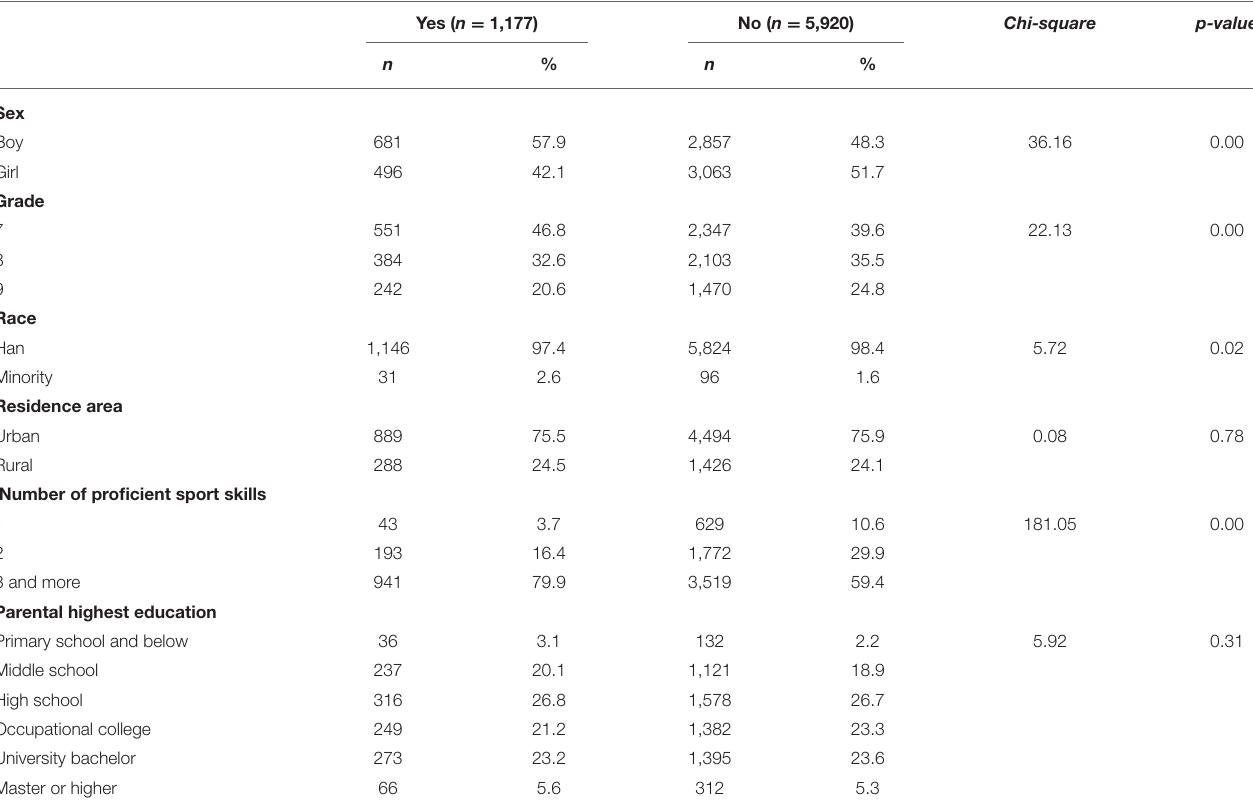
TABLE 2 | Prevalence of participation in organized sports activities by sociodemographic variables. Yes ( n = 1,177) No ( n = 5,920) Chi-square